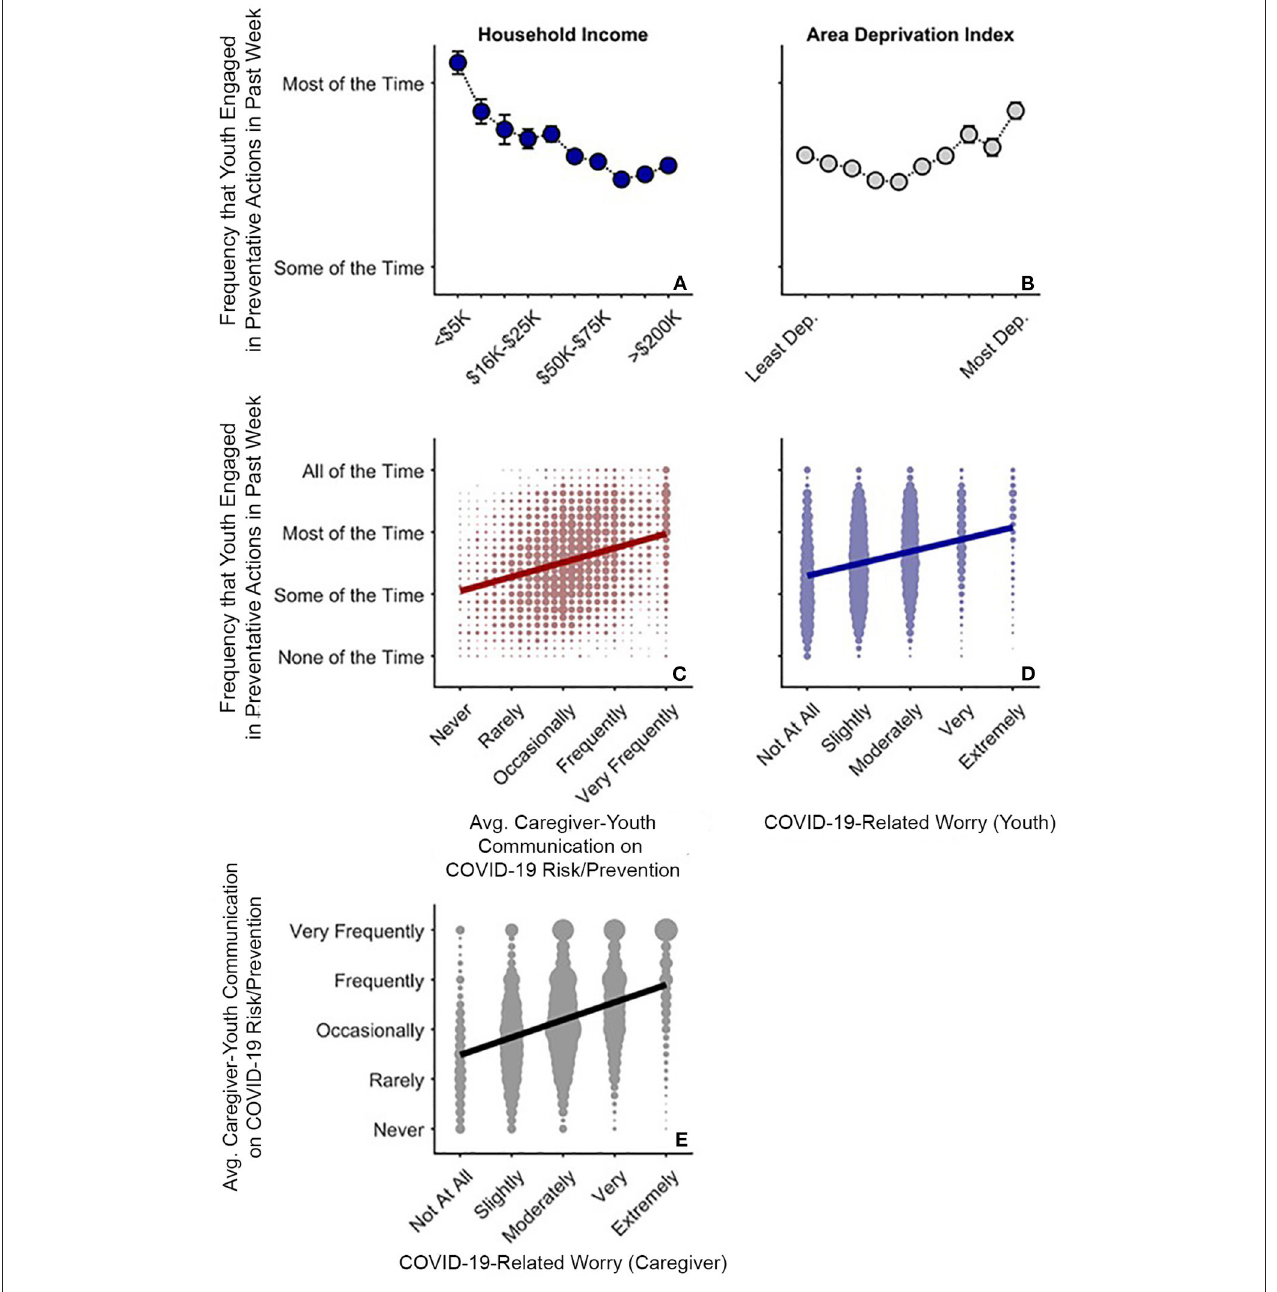
FIGURE 6 | COVID-19 risk and prevention as functions of COVID-19-related worry in caregivers and youth. (A,B) Average (Avg.) frequency that youth endorsed COVID-19-related preventative behaviors as functions of annual household income and area deprivation index. Error bars are ± 1 between-subjects standard error of the means. Analysis controlled for caregiver education, child race, ethnicity, sex, and age, questionnaire number, participants’ baseline study site, and participant. Area deprivation index was collapsed across continuous deciles for graphing. (C) Frequency of youths’ preventative behaviors by caregiver-youth risk/prevention communication frequency (i.e., averaged data from Figure 4 ). (D) Frequency of youths’ preventative behaviors by youth COVID-19-related worry. (E) Frequency of caregiver-child risk/prevention communication by caregiver COVID-19-related worry. (C–E) Circle size reflects the number of datapoints at each x-y coordinate. Solid lines are best fitting simple regression